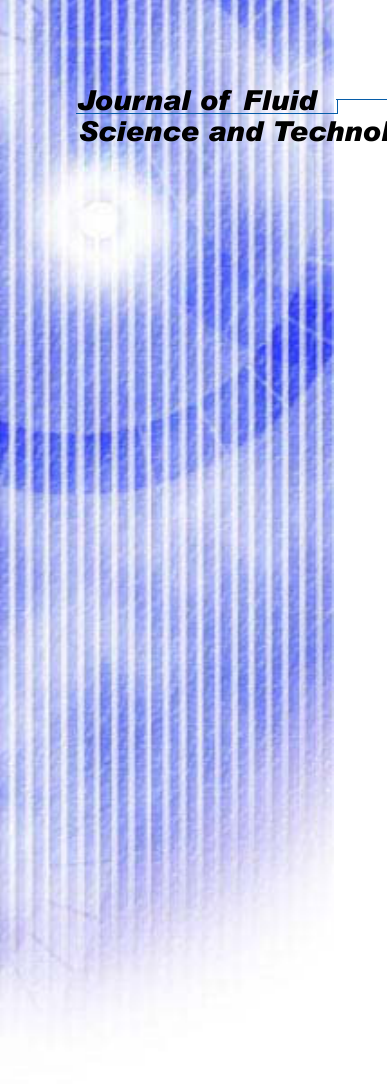
Fig. 5 Sherwood number of a bubble in stagnant Millipore water.